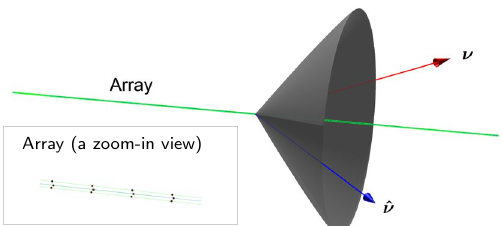
Fig. 2 The beampattern of a conventionally beamformed towed multiplet line array has a nearly conic